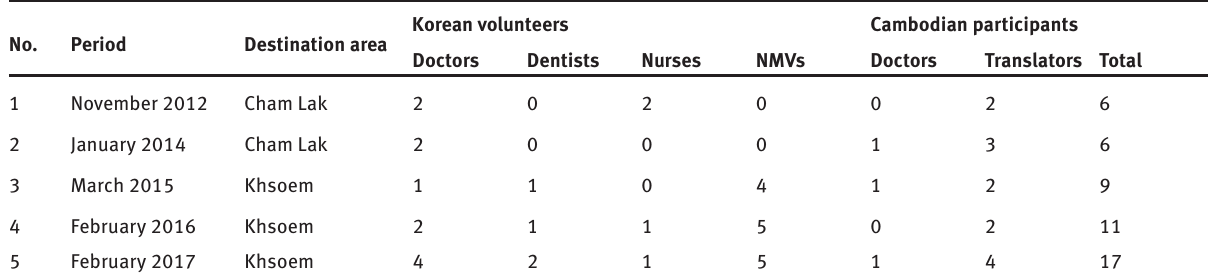
Table 1: Number and occupation of personnel in missions